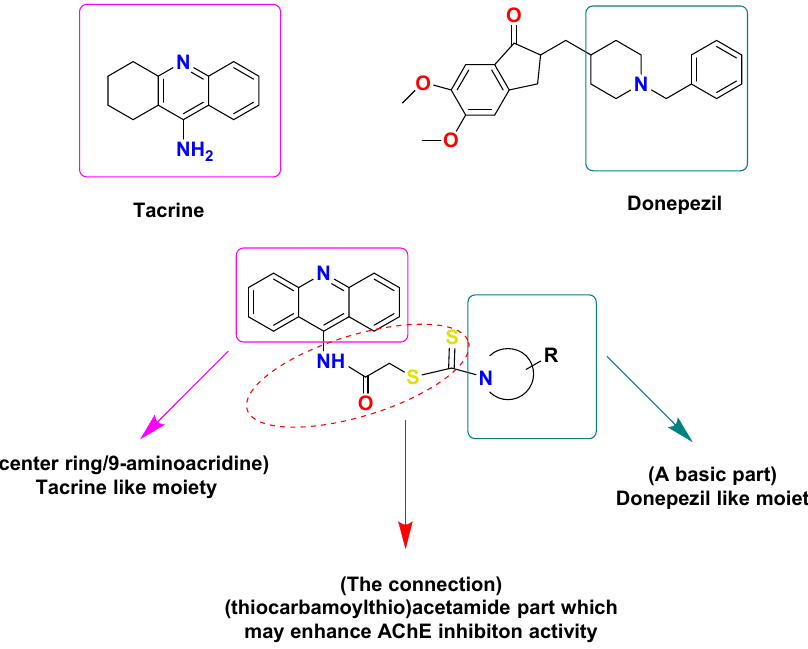
Figure 1. Design strategy of recently synthesized derivatives.